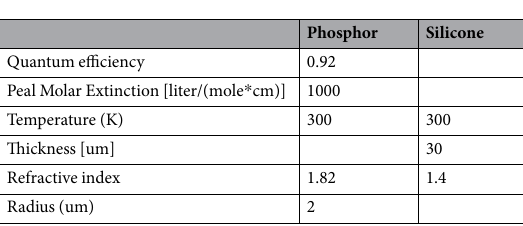
Figure 9. TracePro structures with 128 phosphor particles.